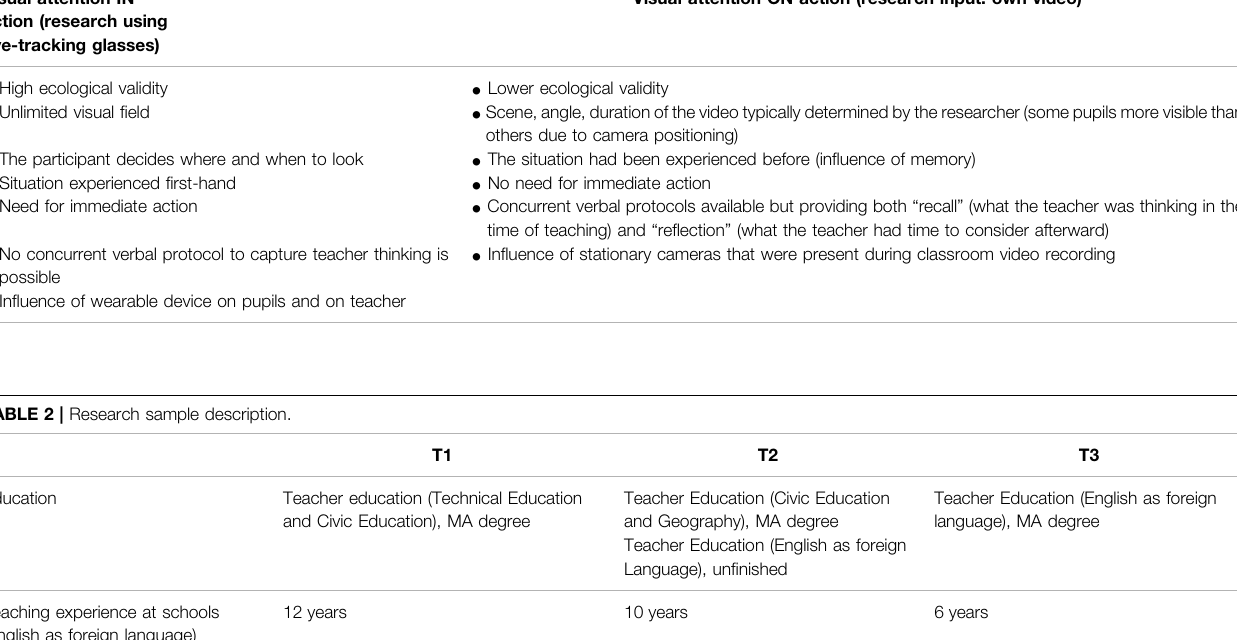
TABLE 1 | Research differences of visual attention IN and ON action.